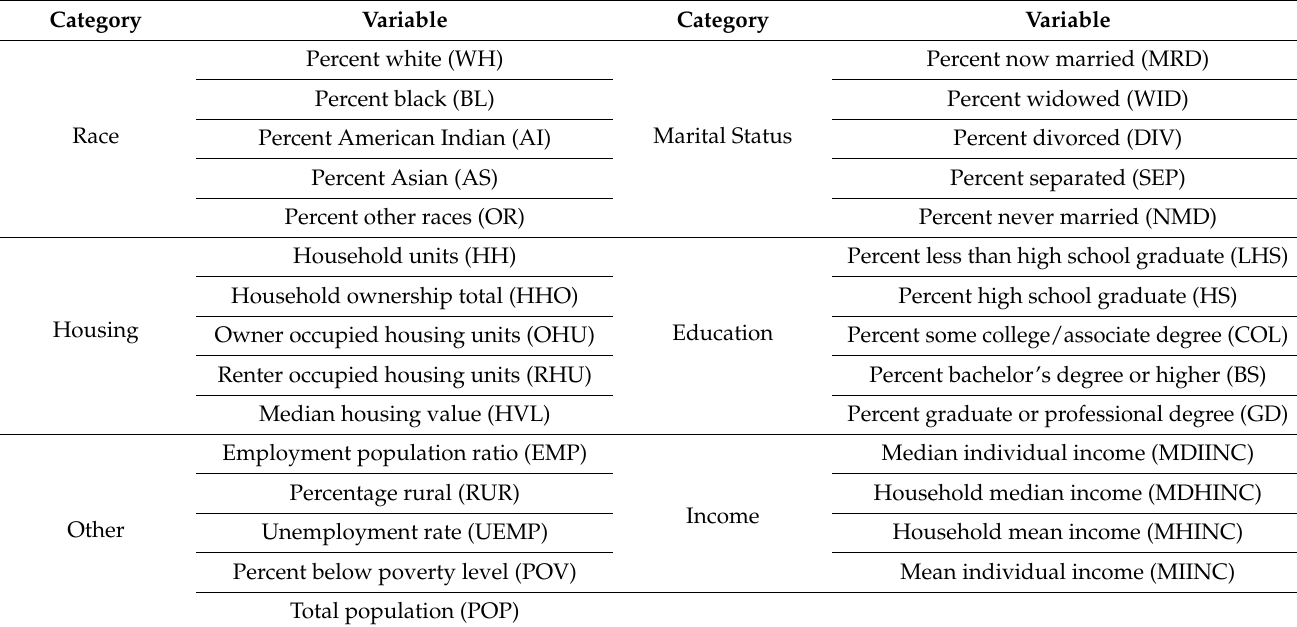
Table A1. List of Socioeconomic and Demographic Variables.